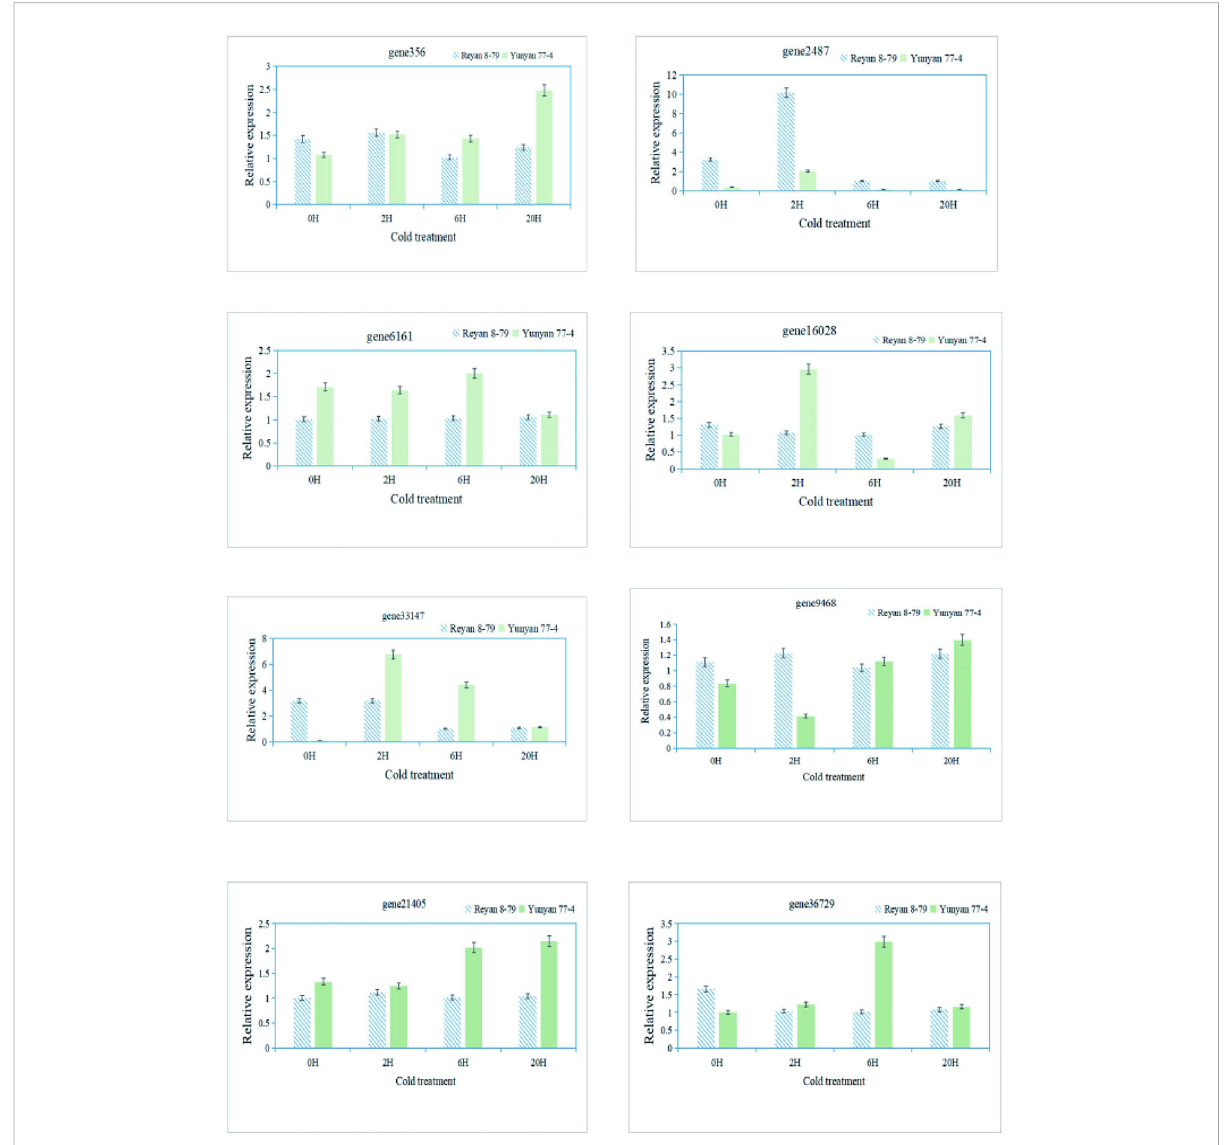
FIGURE 6 qRT-PCR validation of the transcript levels of DEGs of the arginine and fl avonoid biosynthetic